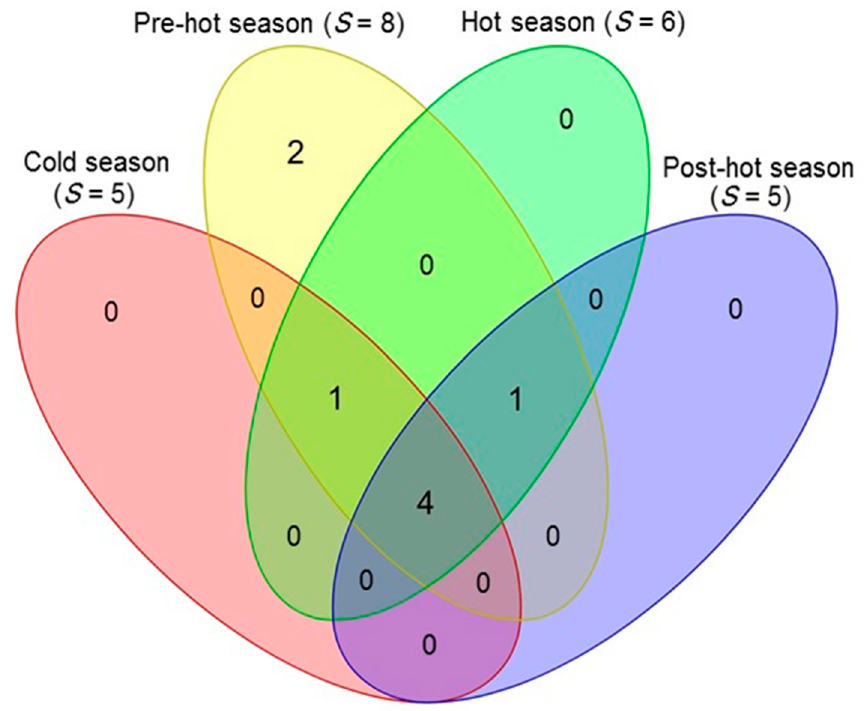
Figure 5. Venn diagram explaining the distribution of number of scorpion species according to seasons in the Ghardaïa region, Sahara Desert of Algeria. Table 4. Similarity analysis (in %) between number of scorpions and seasons in the region of Ghardaïa,